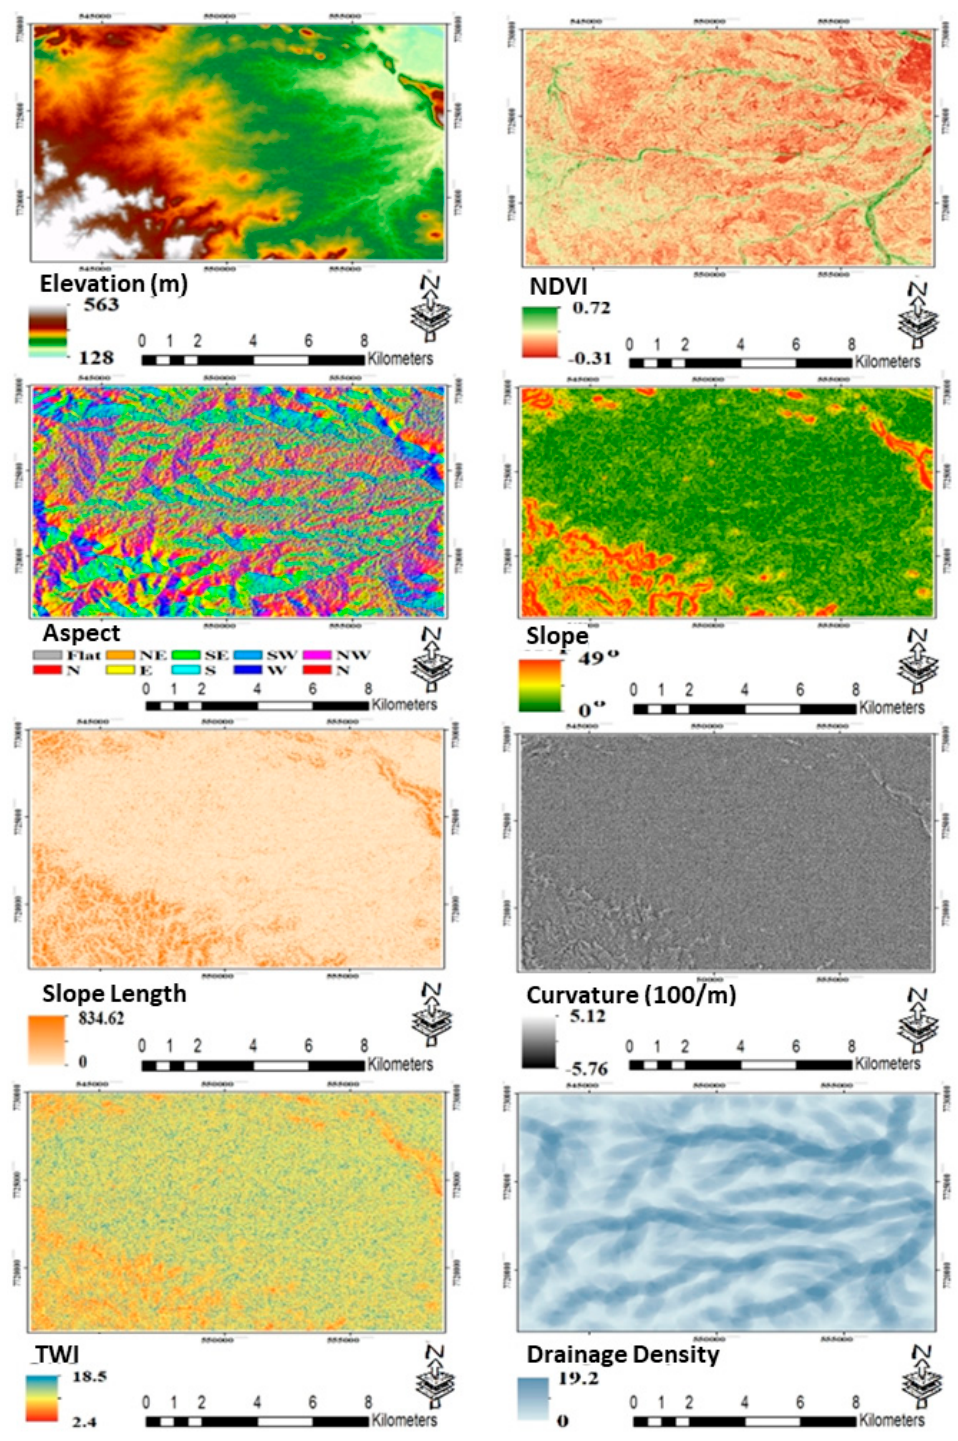
Figure 3. Conditioning factors used for gully networks detection.